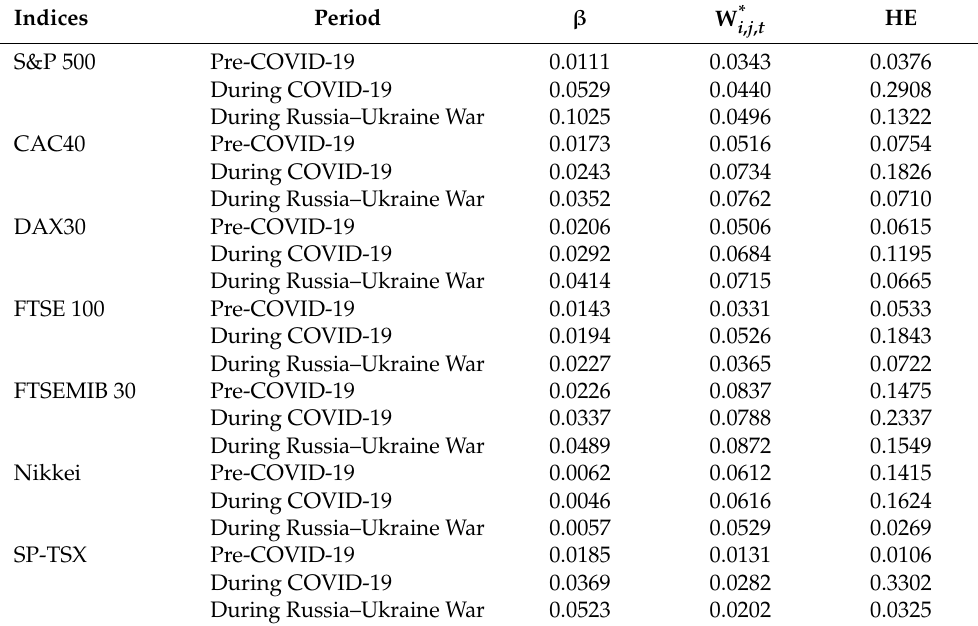
Table 4. β , W ∗ , and HE for a Bitcoin-G7 indices portfolio. i , j , t